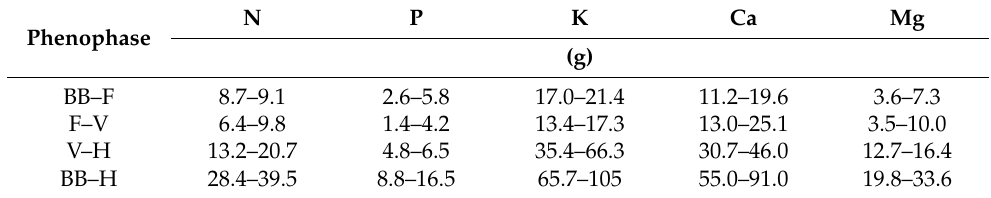
Table 12. Amount (min.–max.) of nutrients supplied per period and per plant z